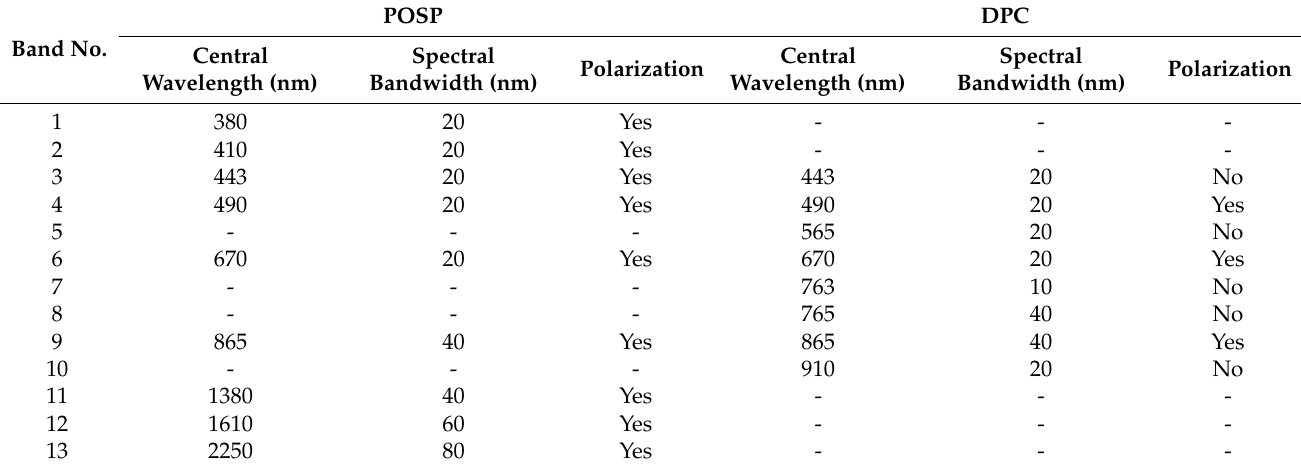
Table 1. Spectral parameters of the PCF